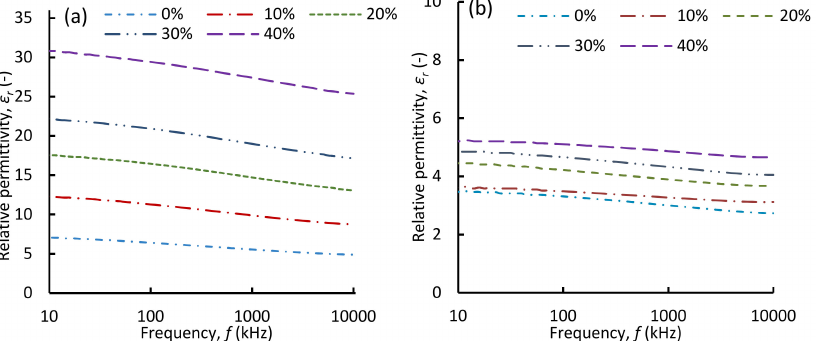
Figure 6. Broadband relative permittivity of ( a ) solid ( b ) foamed at ϕ = 2 of TPU/PZT composites at various PZT loadings up to 40 vol